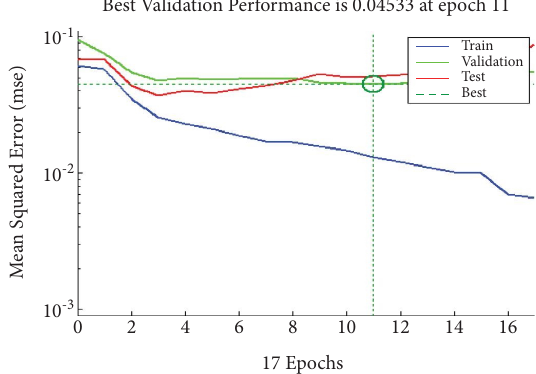
Figure 2: Neural network training